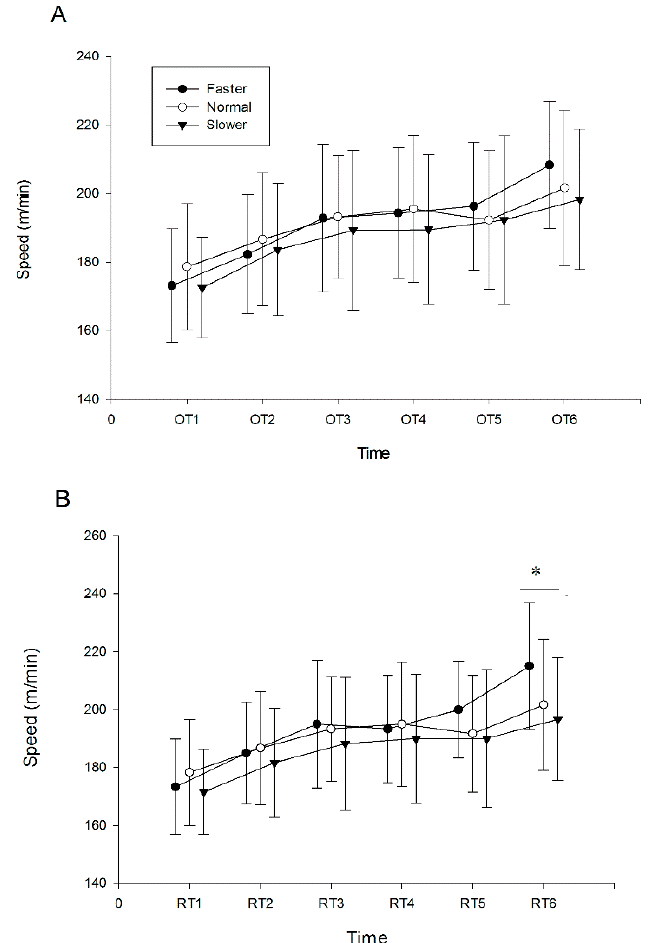
Figure 3. Speed (m/min) in the ( A ) observed Time (OT) and ( B ) real time (RT) analysis. Mean ( ± SD) data for speed for each condition with respect to ( A ) OT (every 10-min period of the observed time) and ( B ) RT (every 10-min period of the real time). Notes: * Significant differences between FC and both NC and SC.